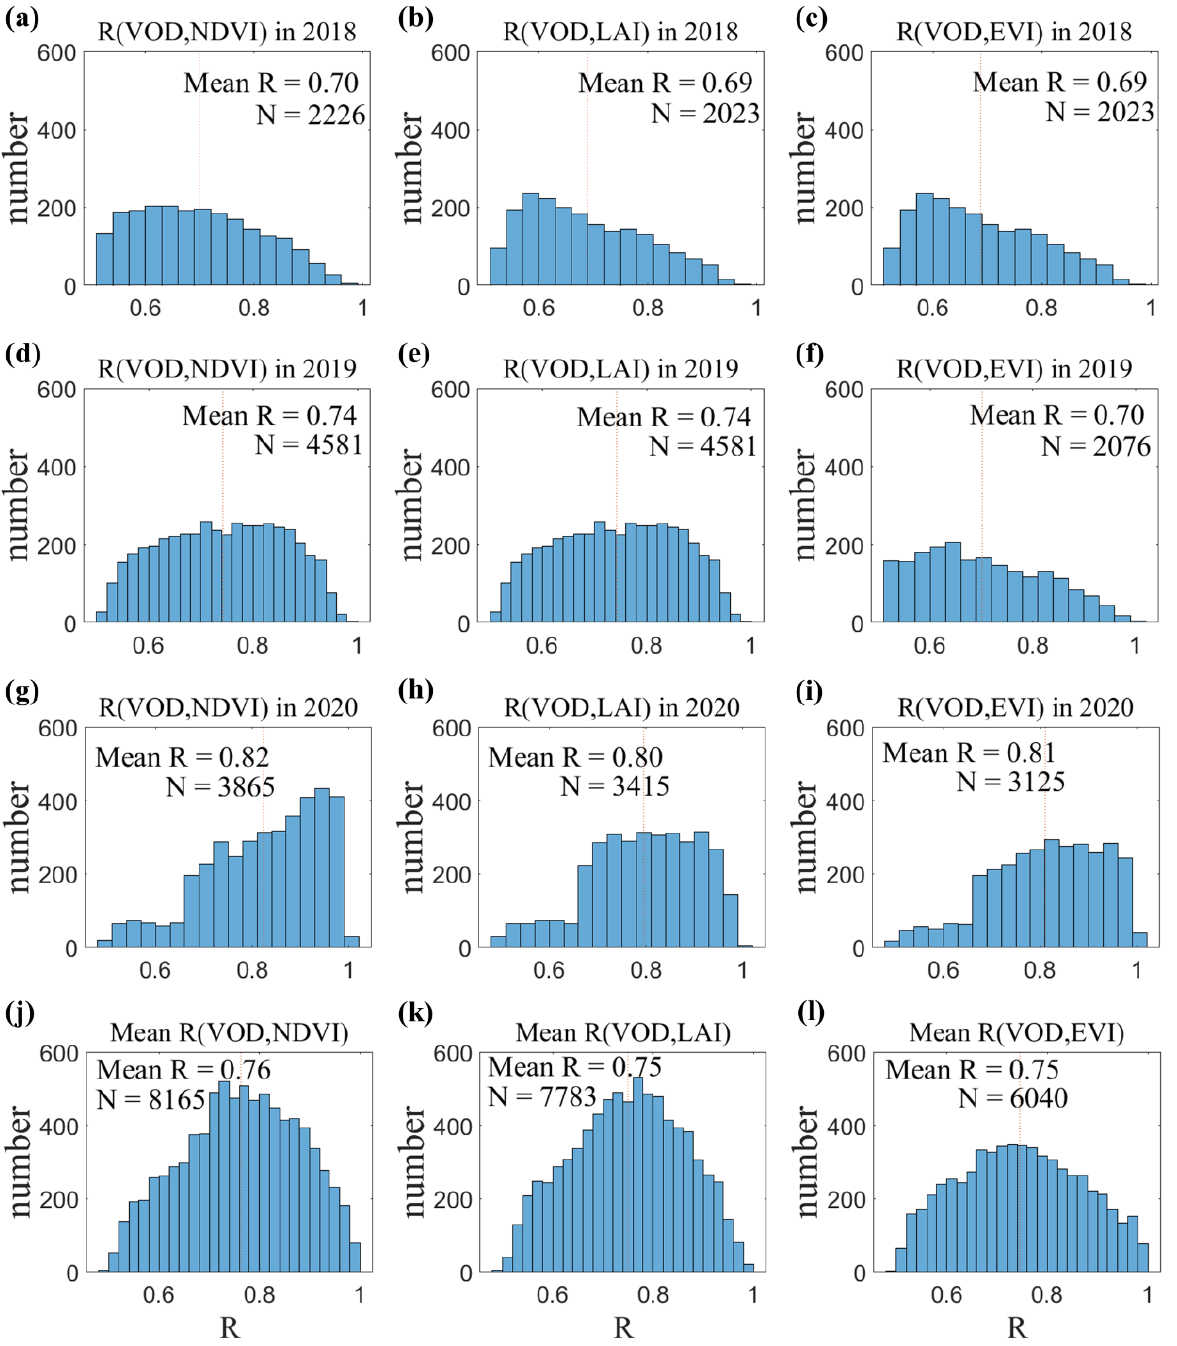
Figure 9. Histograms of temporal correlation coefficient (R) between VOD (from top to bottom: VOD in 2018 ( a – c ), VOD in 2019 ( d – f ), VOD in 2020 ( g – i ), the three yearly average VOD ( j – l )) and three MODIS VIs (from left to right: NDVI, LAI, EVI). The red vertical line represents the mean value of R for each year.